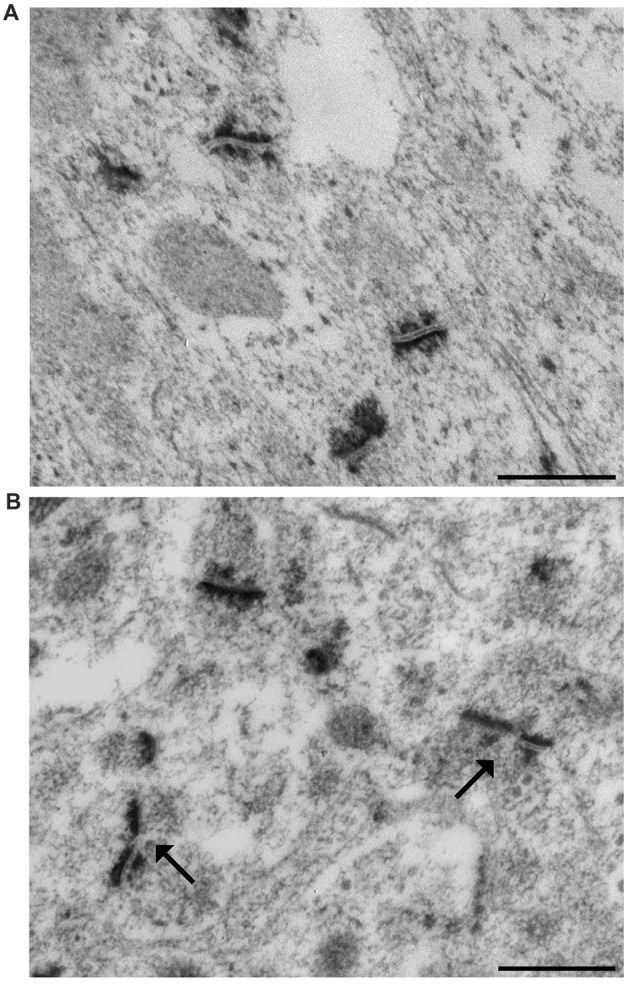
Representative transmission electron micrographs of synapses in the mouse hippocampus. (A) The ethanol phosphotungstic acid (E-PTA) technique evidences the synaptic contact zones against an unstained background and enables reliable measurements of synaptic ultrastructural features. (B) Arrows indicate two perforated synaptic contacts: pre-synaptic apposition appears as a range of peaks, while the post-synaptic junction appears as a dark uniform line. Bars: 500 nm.